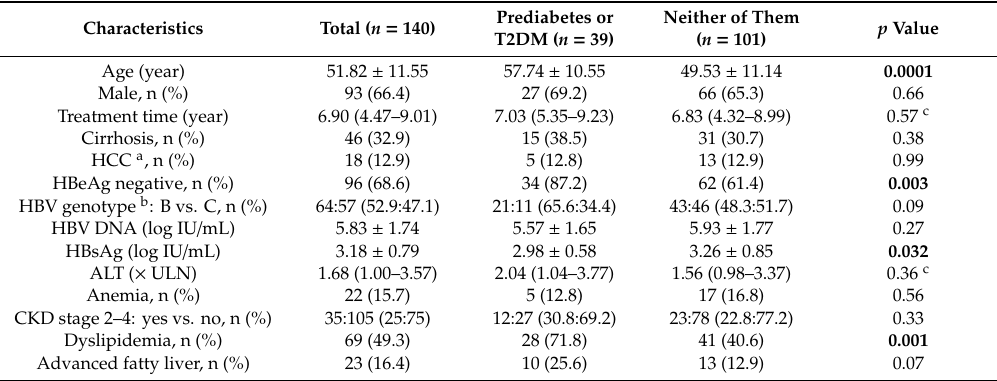
Table 1. Clinical characteristics of the 140 enrolled patients, categorized by with prediabetes or type 2 diabetes mellitus (T2DM) or neither of